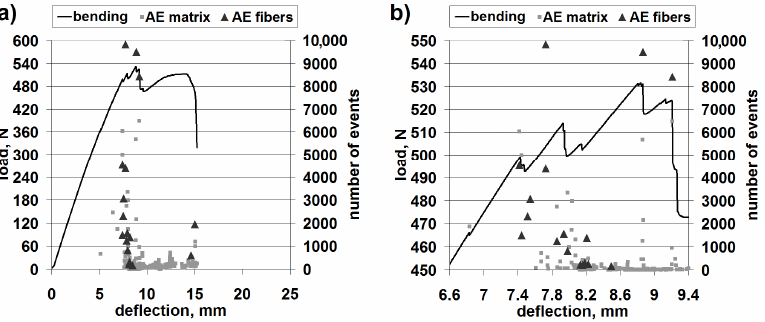
Figure 7. Mechanical curve and separated AE signal for 3D laminate, direction W : ( a ) The whole progress; ( b ) Magnification of the crucial fragment.